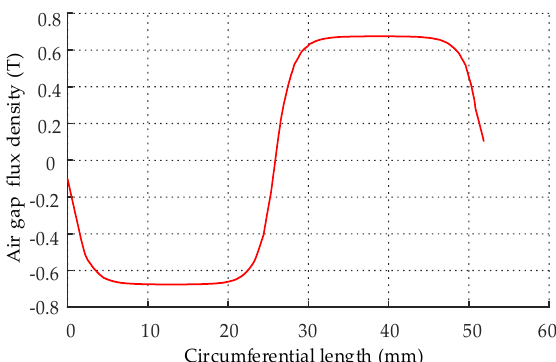
Figure 6. Air-gap flux density waveform in an average radius.